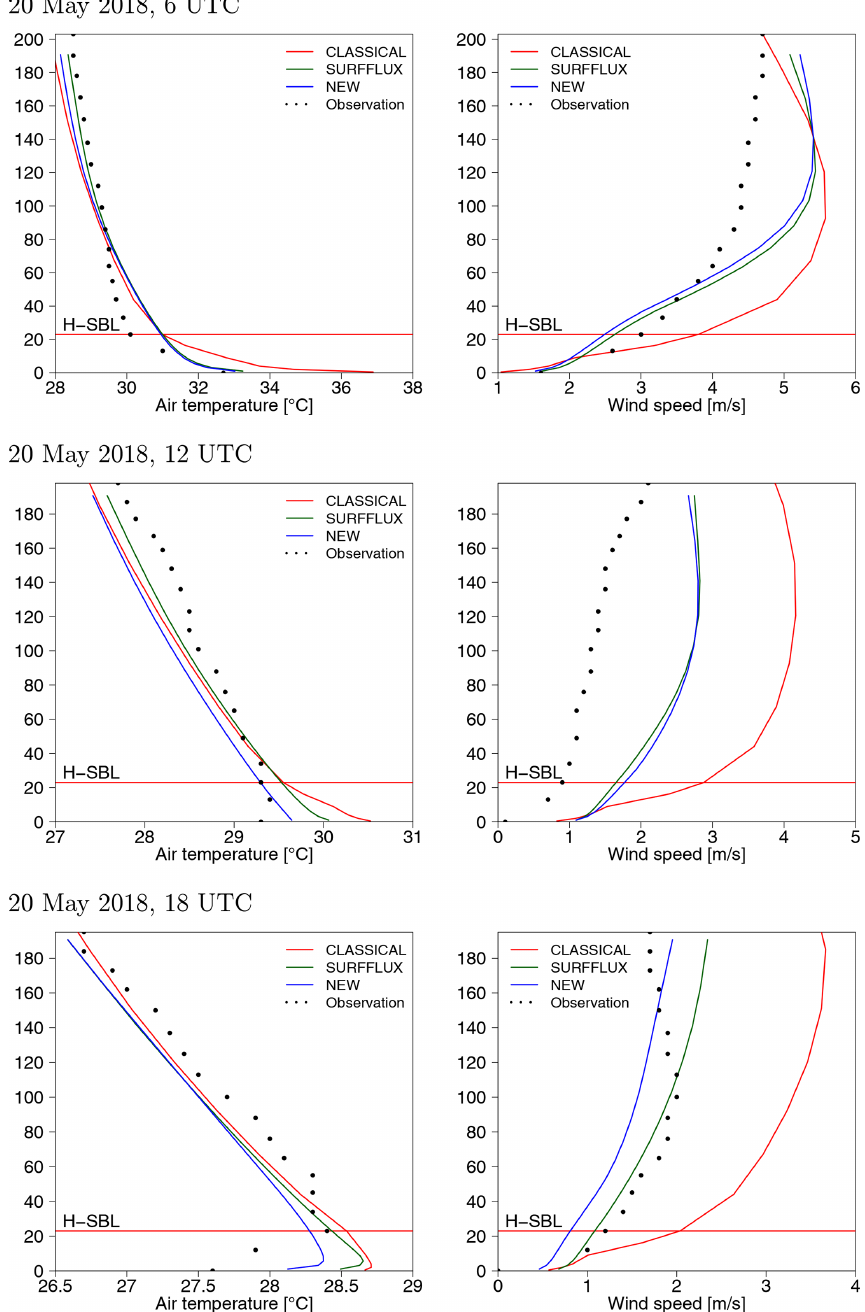
Figure 11. Vertical profiles of air temperature and wind speed at the KP station. H-SBL indicates the height below which for CLASSICAL the meteorological variables are taken from the SBL